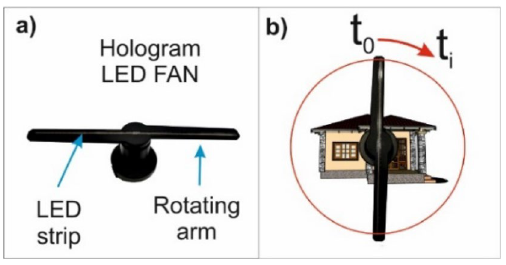
Figure 3. Diagram of LED hologram operation: ( a ) LED hologram elements, ( b ) general operation diagram. Source own